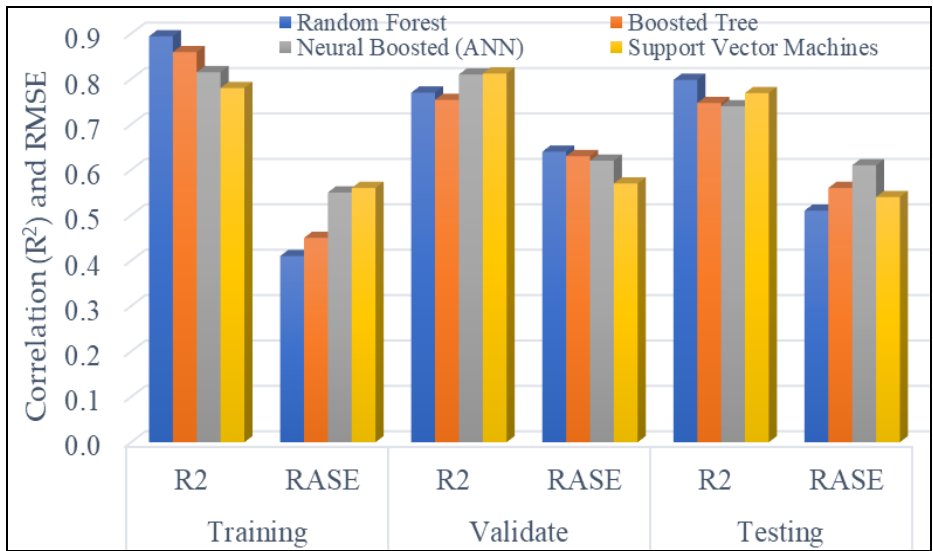
Figure 11. The bar plots to display and compare 4 supervised machine learning methods to predict FZI log. The Random Forest method shows the best result with highest R 2 = 0.894 and lowest RASE = 0.41 on the training section. Table 4. Summary results of R 2 and RMSE after running four ML methods. Supervised Methods